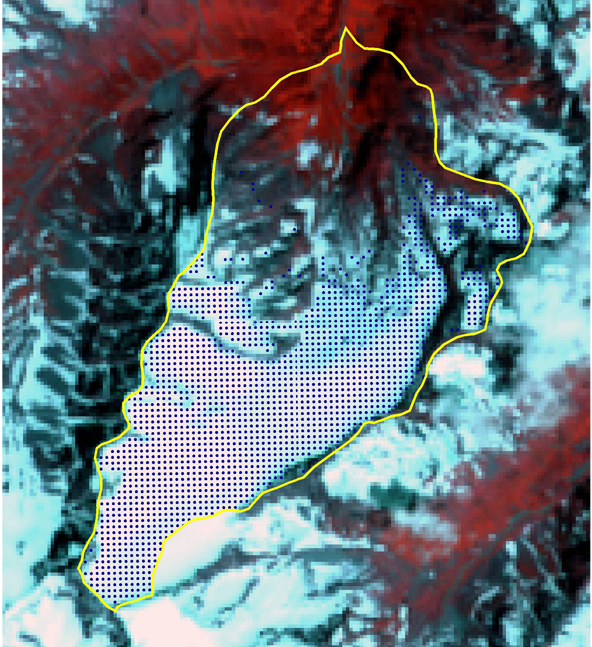
Fig. 2. Landsat image of Lisens catchment on 30 June 2001 showing an overall agreement between observed and simulated (blue dots) snow cover of 89 % (statistical scenario features of this snow state: SCQ=30%, SWE=SWE m , max )